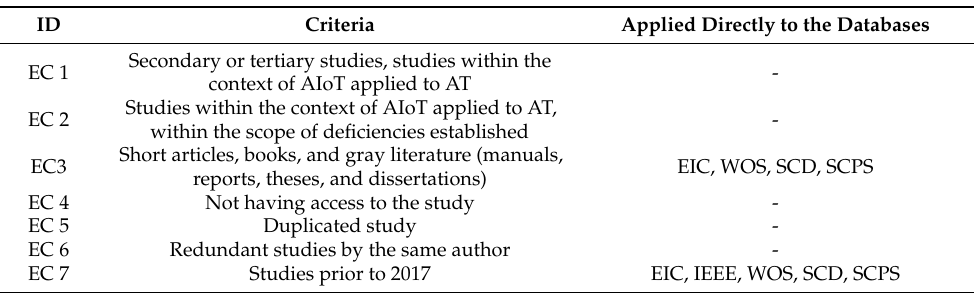
Table 5. Exclusion